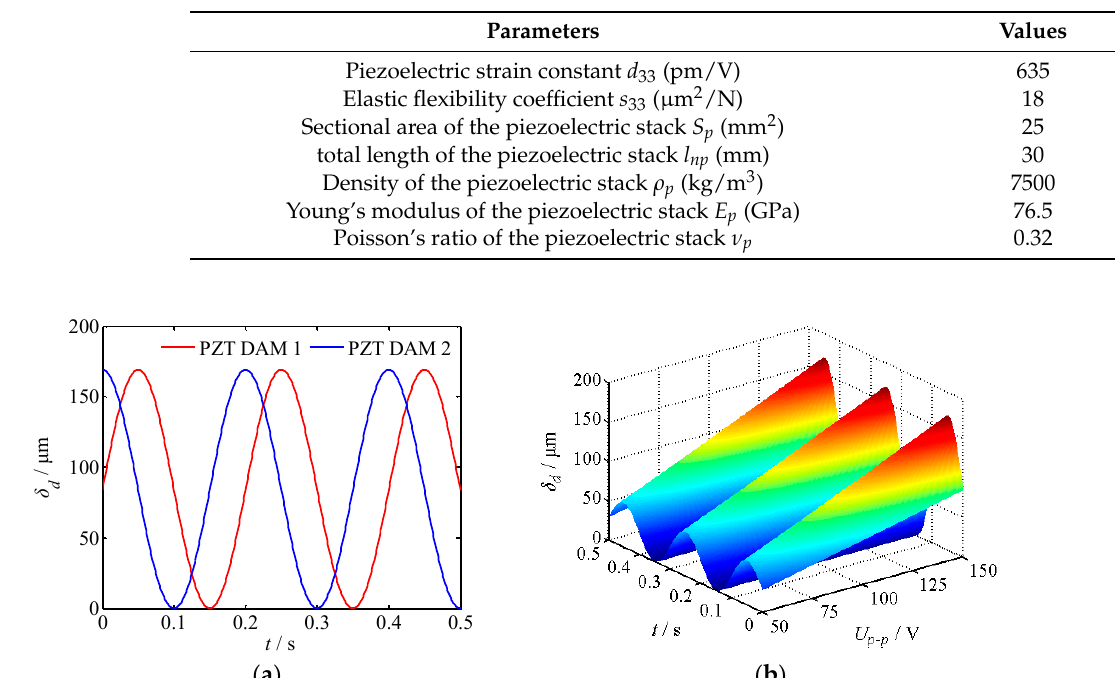
Figure 5. Output displacement curve of piezoelectric displacement amplification mechanism. ( a ) The displacement in both directions varies with time; ( b ) The unidirectional displacement varies with time and peak–peak voltage.